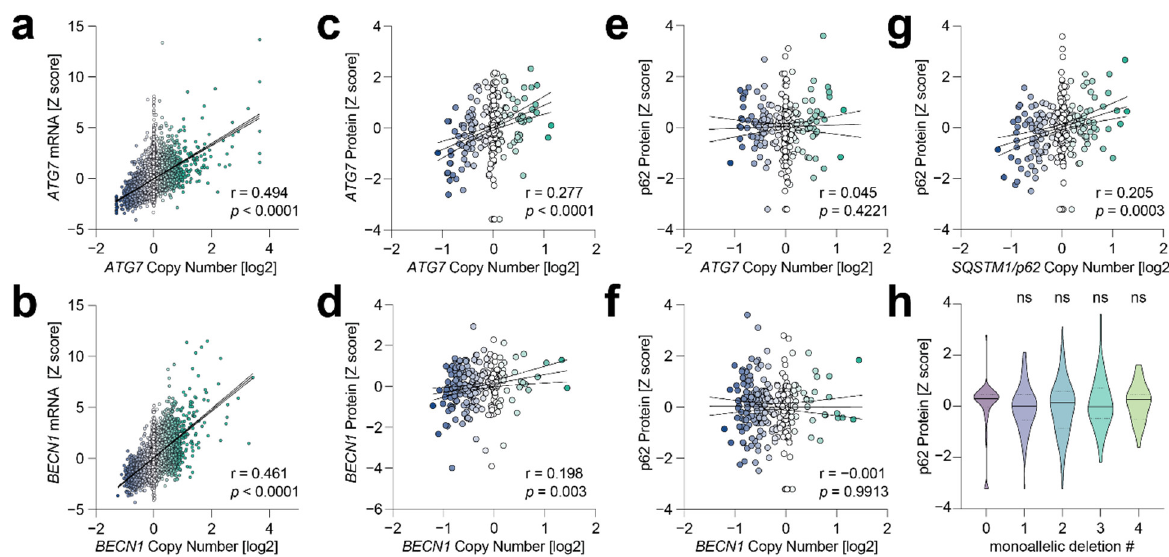
Figure 6. TCGA Pan-Cancer Atlas analysis. ( a , b ) Correlation analysis between gene copy number (log2-transformed values) and mRNA expression (Z-scores relative to diploid samples). Shown are individual tumors ( n = 9889), the linear regression line with 95% confidence interval, the Spearman r correlation coefficient, and p value. ( c , d ) Correlation analysis between gene copy number (log2- transformed values) and protein expression Z-scores measured with mass spectrometry by the Clinical Proteomic Tumor Analysis Consortium (CPTAC). Shown are individual tumors ( n = 307), the linear regression line with 95% confidence interval, the Spearman r correlation coefficient, and p value. ( e – g ) Correlation analysis between p62 protein expression Z-scores (CPTAC) and gene copy number for ATG7 , BECN1, and SQSTM1/p62 . Shown are individual tumors ( n = 308), the linear regression line with 95% confidence interval, the Spearman r correlation coefficient, and p value. ( h ) p62 protein expression Z-score of patient samples ( n = 307) stratified according to the number of autophagy genes ( BECN1 , LC3 , ATG10, and ATG7 ) harboring shallow (nonhomozygous) deletions. Violin plots show the median and interquartile ranges; 1-way ANOVA with Dunnett’s multiple comparisons test. Pairwise comparisons to samples with no deletion in the analyzed autophagy genes were not significant (ns).